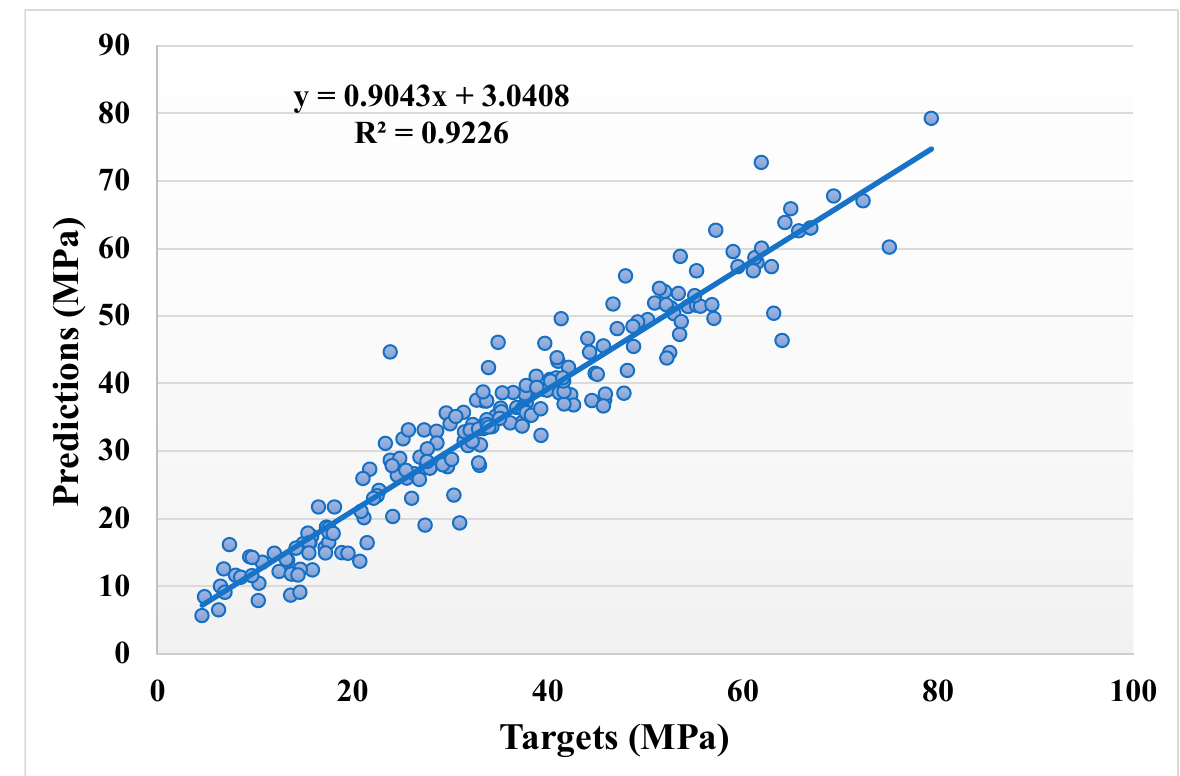
Figure 3. Relationship between the actual and predicted results of the bagging model.